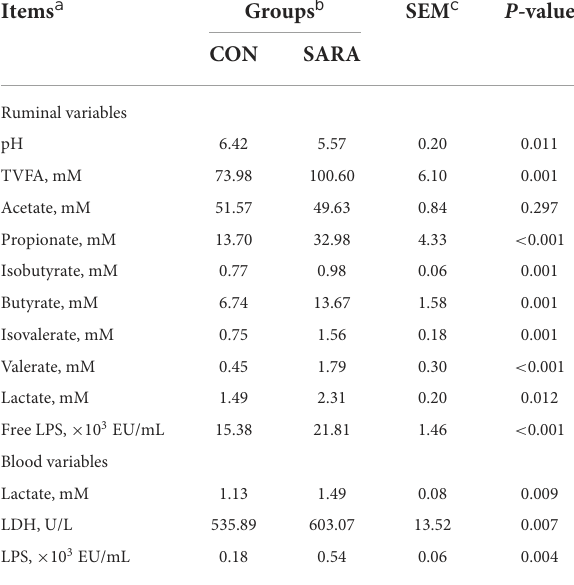
TABLE 4 Effect of subacute rumen acidosis on rumen fermentation and blood parameters.